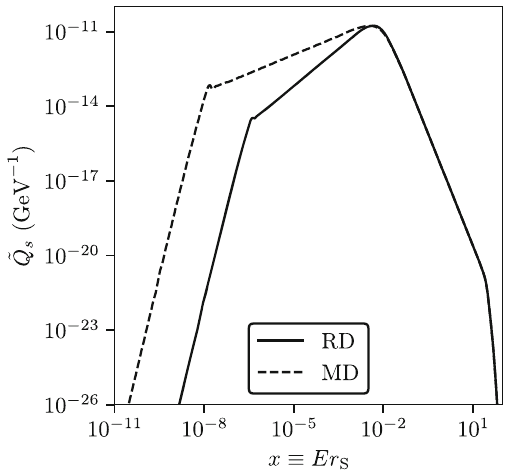
Fig. 2 Stacked graviton spectrum emitted by a M BH = 10 − 1 g SchwarzschildBH,inthecaseofradiationdomination(RD,solidblack) or matter domination (MD, dashed